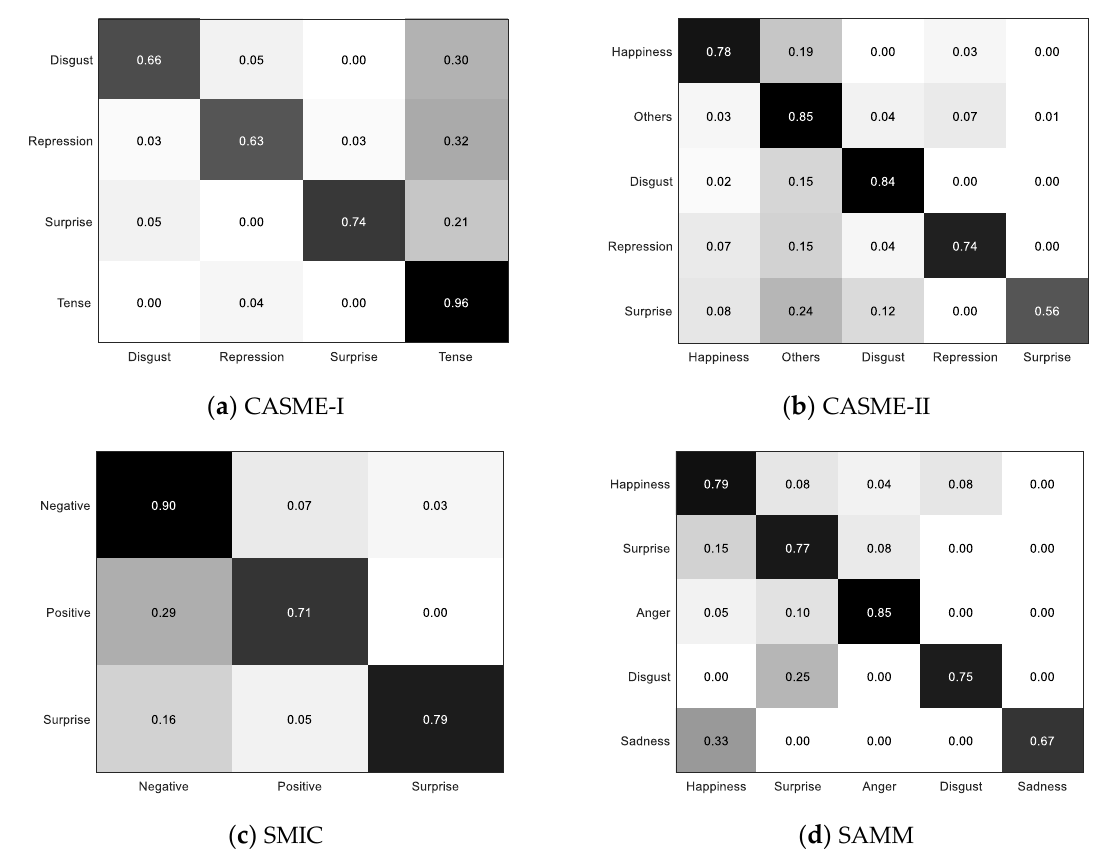
Figure 8. The accuracy of each subject for the predictions on CASME-I, CASME-II, SMIC, and SAMM, respectively.